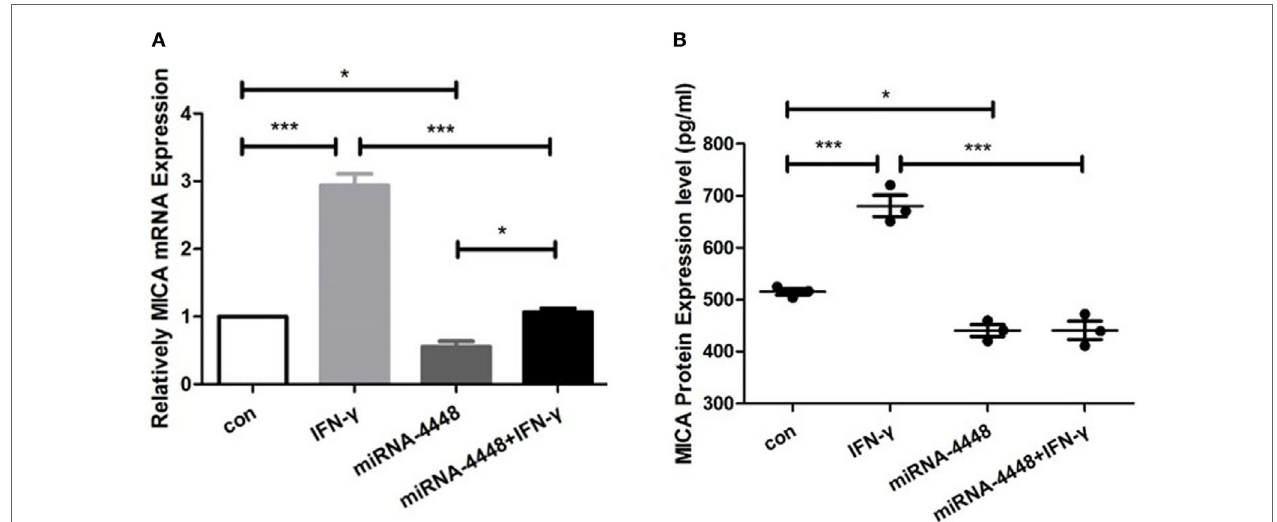
FigUre 4 | miRNA4448 is IFN- γ responsive, and the overexpression of miRNA4448 decreased MICA mRNA and protein expression levels in human corneal epithelial cells (HCECs). Based on (a) qRT-PCR (B) and enzyme-linked immunosorbent assay analysis, IFN- γ increased MICA mRNA and protein expression levels in the pLenti-CMV-GFP-NC HCEC line. Transfecting pLenti-CMV-GFP-miR-4448 decreased MICA levels compared with transfecting pLenti-CMV-GFP-NC, whereas IFN- γ treatment partially reversed the MICA mRNA expression. * p < 0.05; *** p < 0.001. Con and IFN- γ : pLenti-CMV-GFP-NC HCEC line. miRNA 4448 and miRNA 4448 + IFN- γ : pLenti-CMV-GFP-miR-4448 HCEC